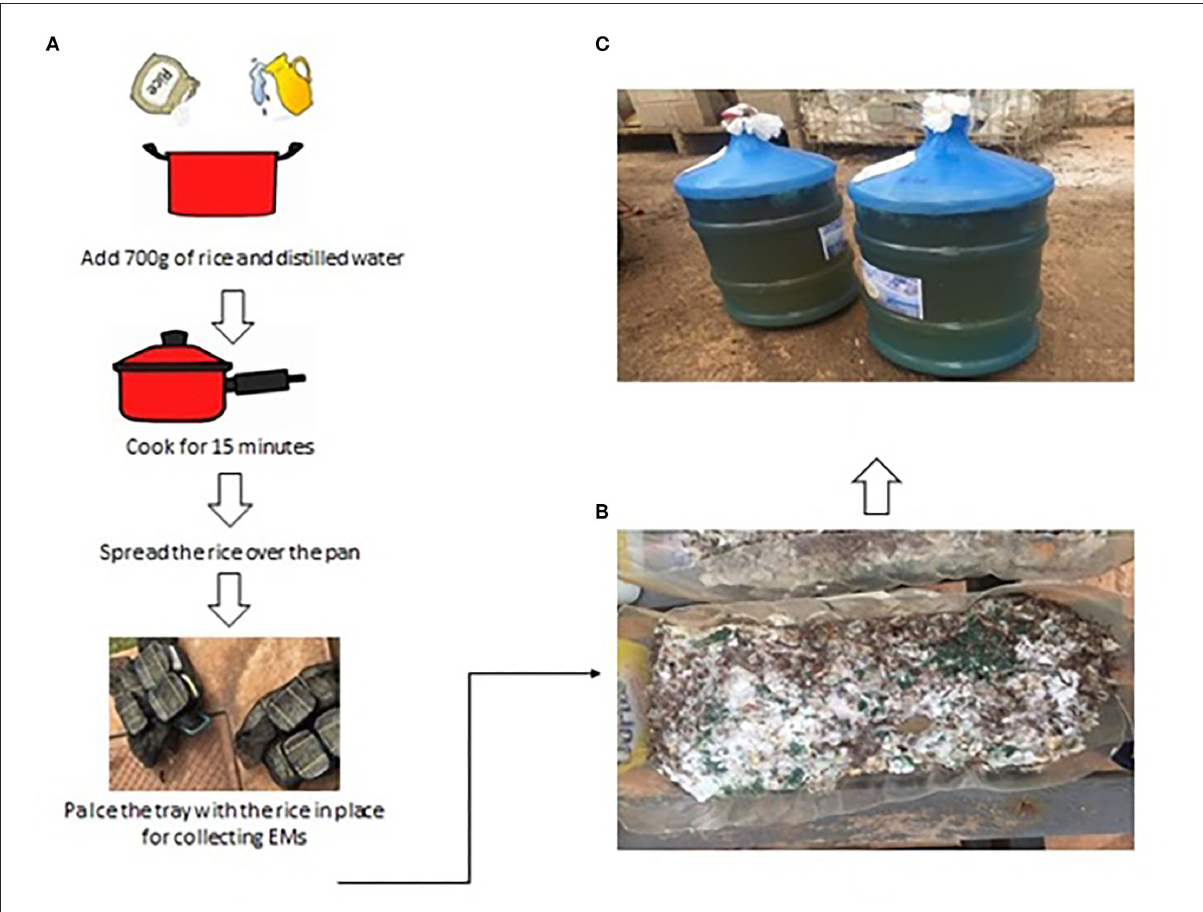
FIGURE1 Process of obtaining and activating EM. (A) Procedures for capturing EM. (B) Aspect of the rice containing the EM before the activation. (C) Activation of EM in sugarcane juice (Nakagawa and Takahashi, 2015) (with adaptations).